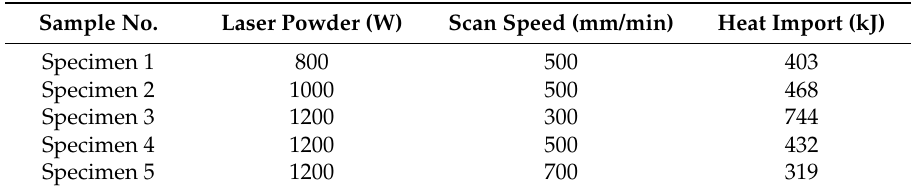
Table 1. Parameters of the laser-cladded Fe–Si–Al coatings. Sample